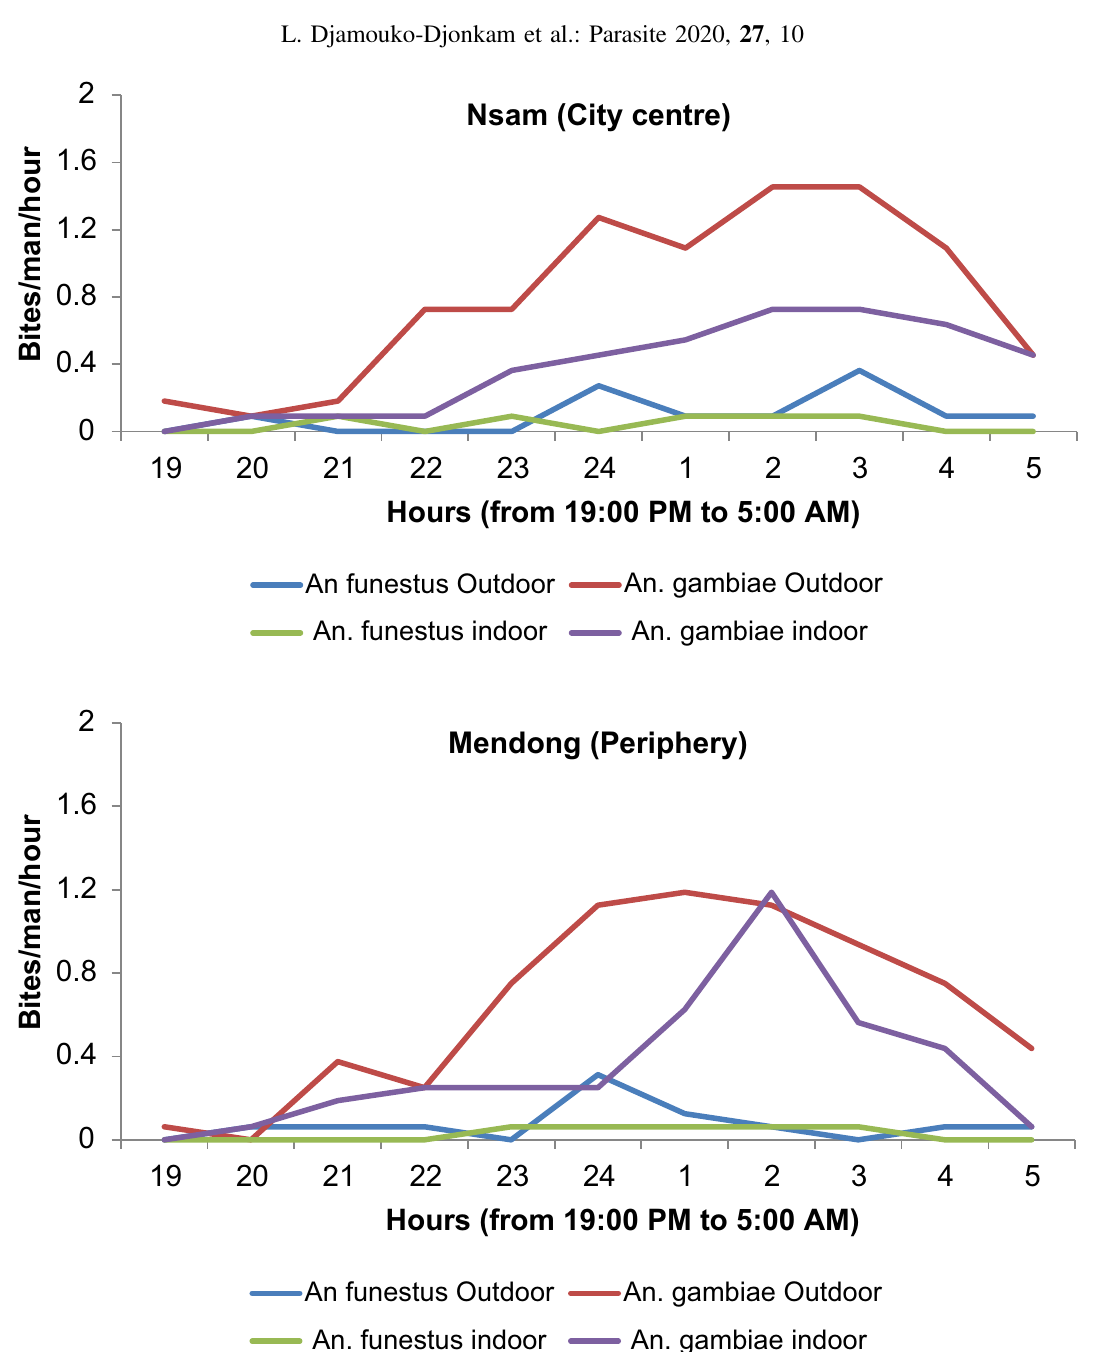
Figure 4. Night biting cycle of An. gambiae s.l. and An. funestus in Mendong and